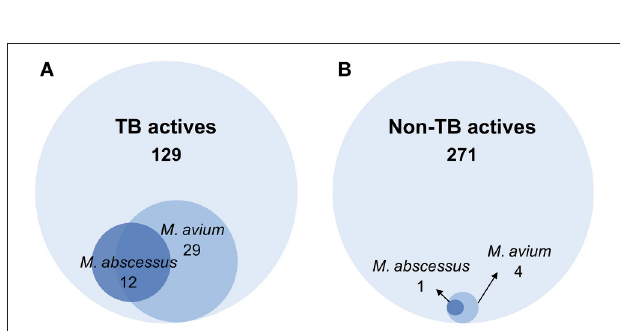
FIGURE 2 | Venn diagrams comparing the number of hits against M. abscessus and M. avium within (A) TB active and (B) non-TB active library compounds. (A) Out of 129 compounds active against M. tuberculosis (TB actives), 12 were active against M. abscessus and 29 were active against M. avium . (B) Among 271 non-TB actives, 1 compound was active against M. abscessus and 4 were active against M. avium . The hit active against M. abscessus also showed activity against M. avium